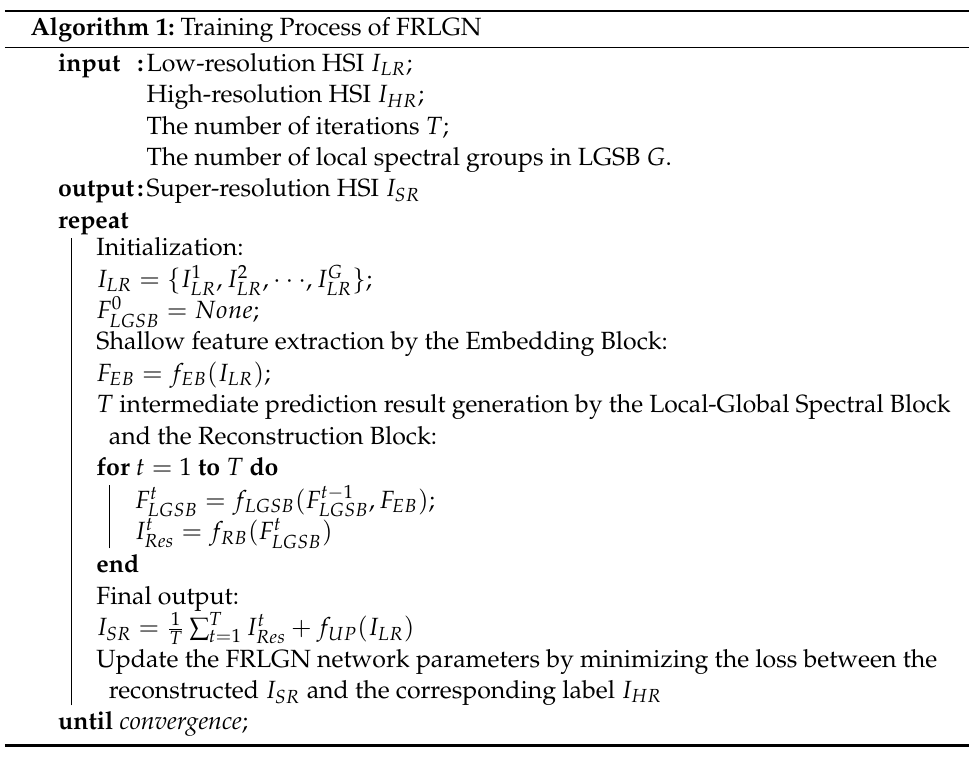
Algorithm 1: Training Process of